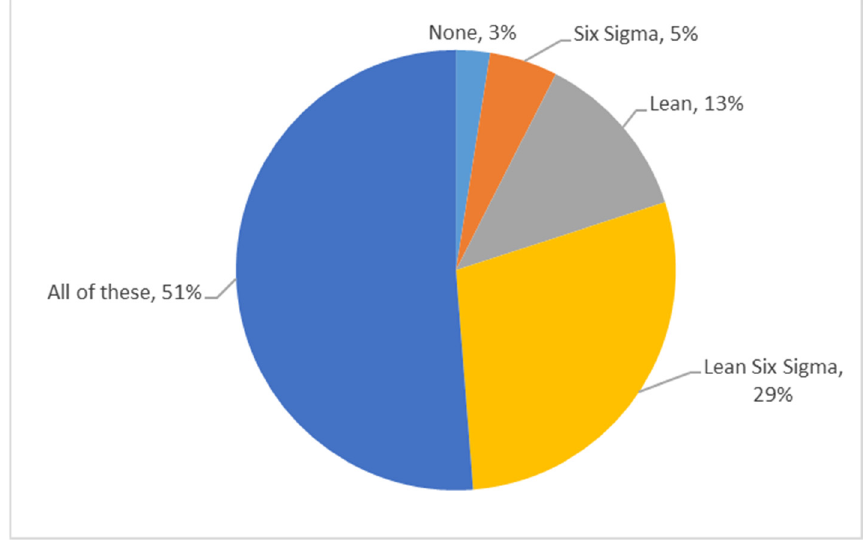
Figure 3. Percentage of the types of CI methodologies used in Irish pharmaceutical organisations.